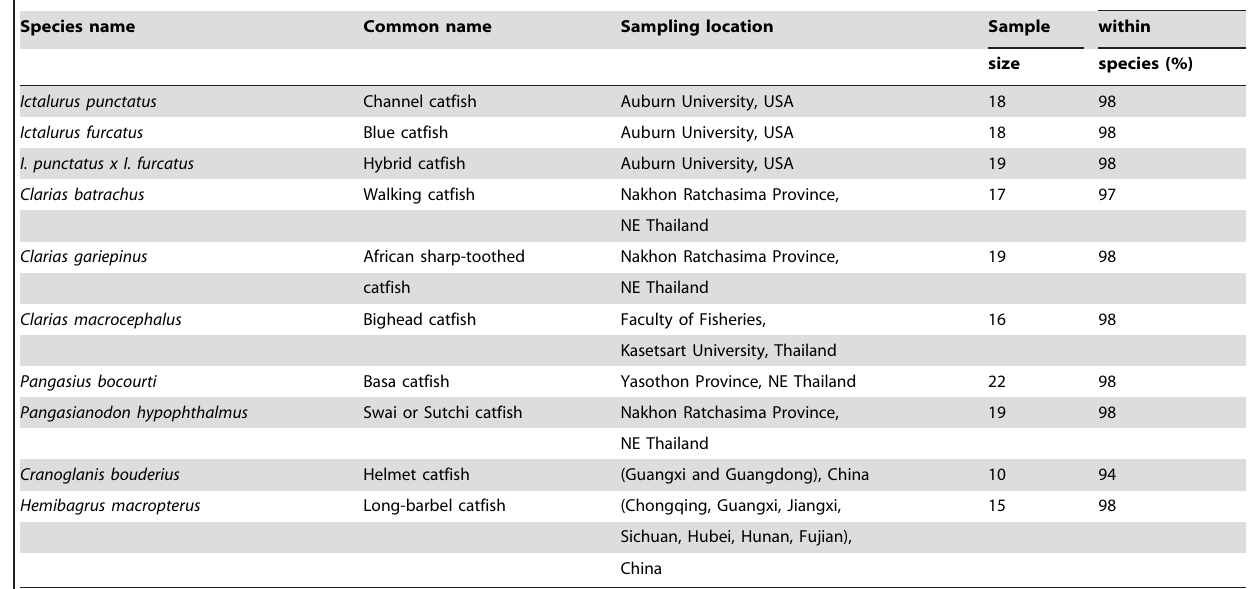
Table 1. Catfish species used in this